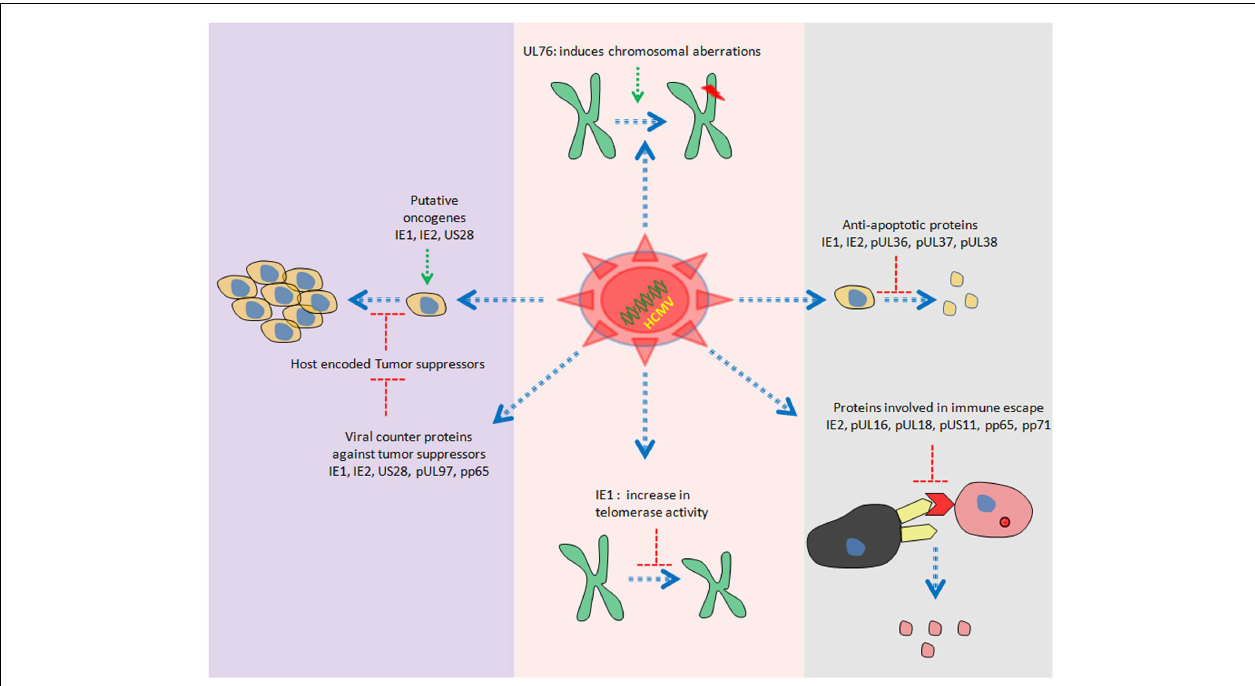
FIGURE 2 | Overview of diverse HCMV proteome involved in modulation of host cell controlled growth